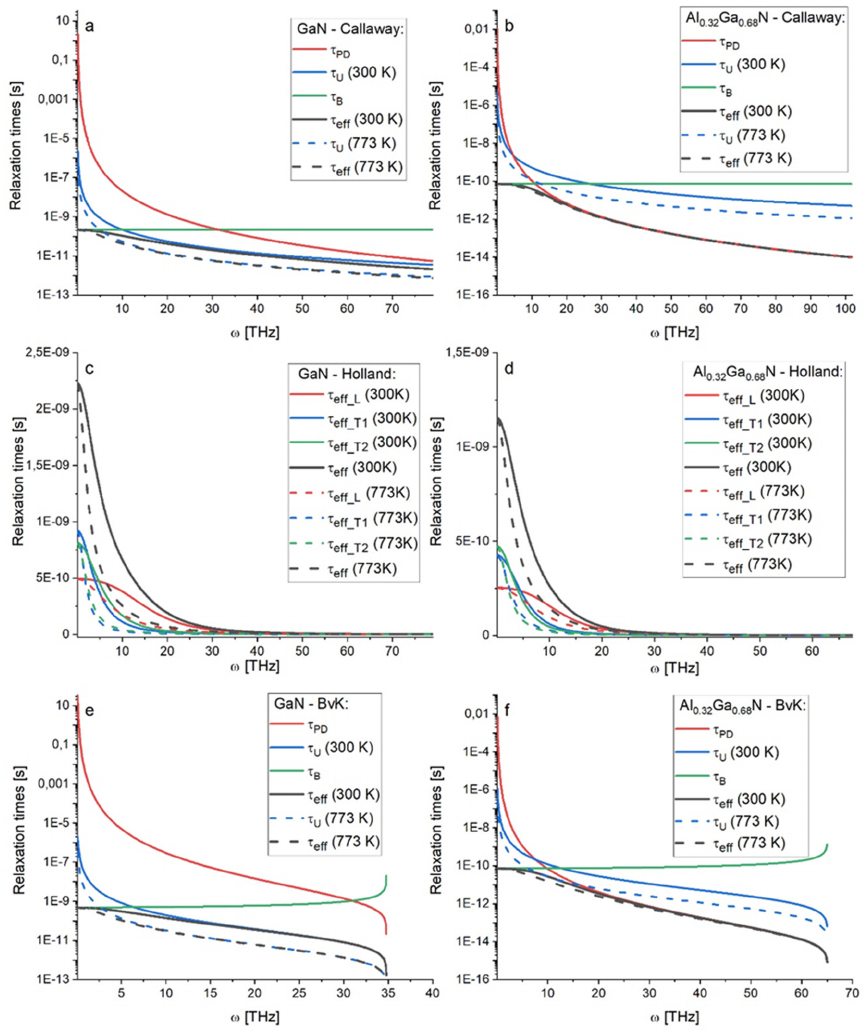
Figure 5. ( a , b ) Frequency dependence of the three di ff erent scattering mechanisms according to the Callaway model; ( c , d ) frequency dependence of the relaxation times for the longitudinal and two transverse phonon branches according to the Holland model; ( e , f ) frequency dependence of the three di ff erent scattering mechanisms of the BvK model. The left-hand side figures ( a , c , e ) are the relaxation times for GaN, and the right-hand side figures are the relaxation times for Al 0.32 Ga 0.68 N.